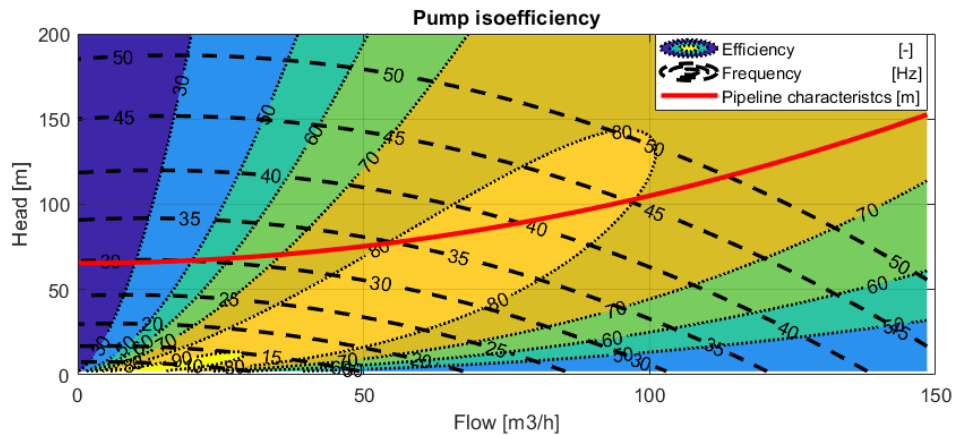
Figure 3. Pump iso-efficiency curve ( H s - Q s - η s